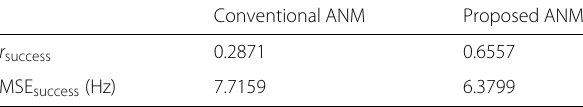
Table 2 Performance comparison of ANM-based algorithms Conventional ANM Proposed